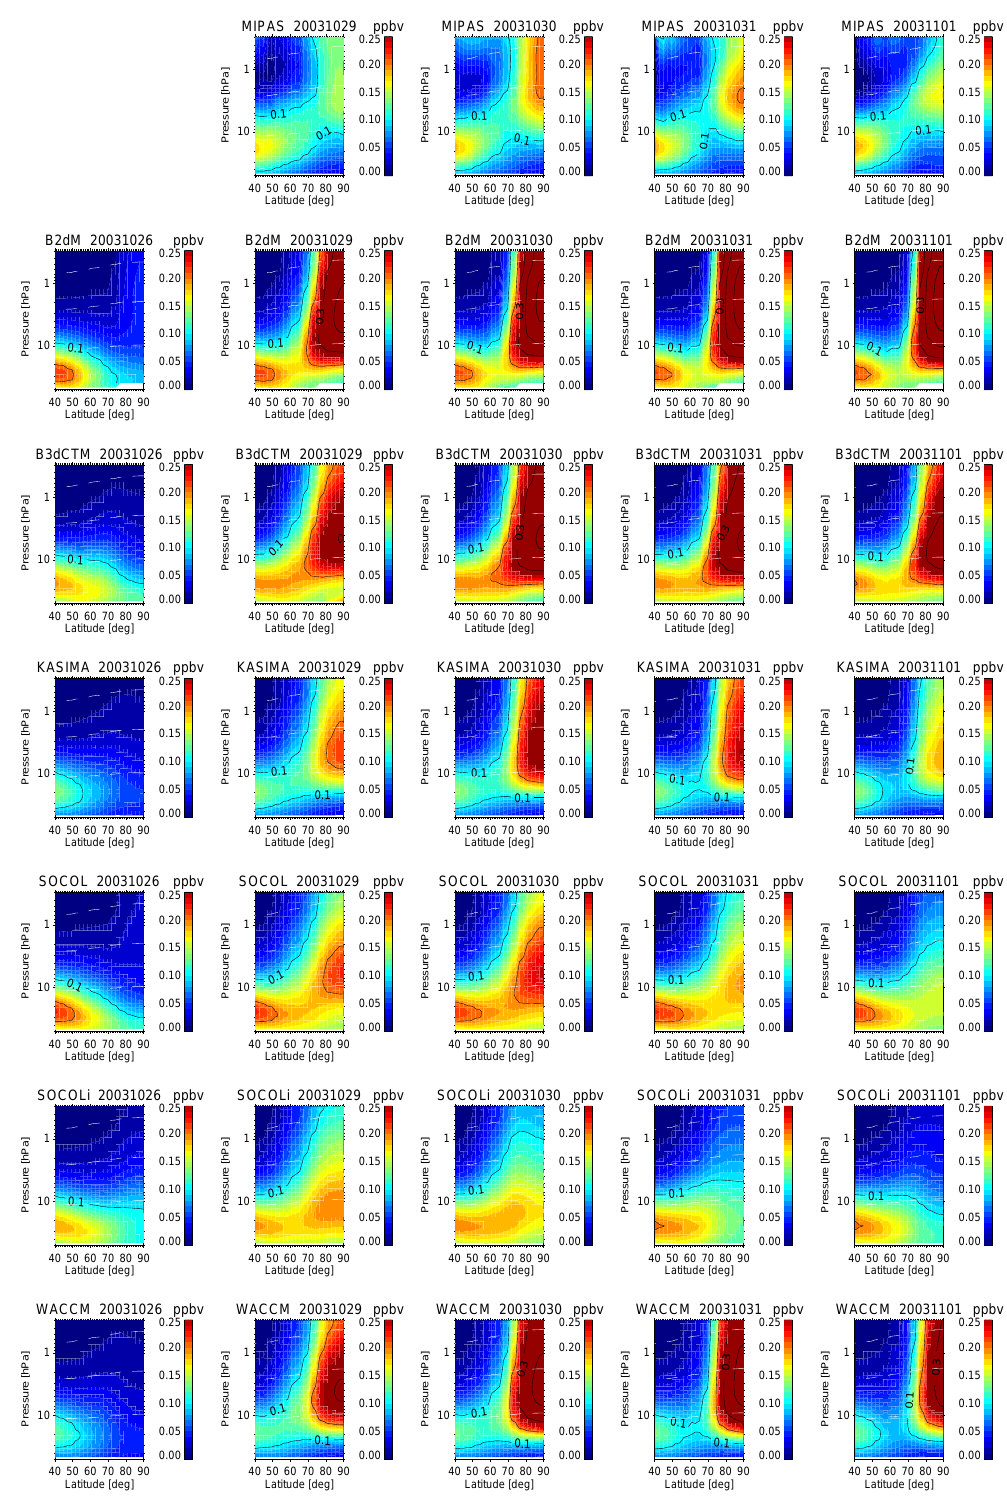
Fig. 25. Observed and modeled zonal mean HNO 4 vmrs for pre-SPE conditions (26 October) and during the main proton forcing (29 October–1 November). Solid contour lines reflect 0.1 ppbv steps. Note that MIPAS observations from 26 October have been omit- ted due to gain calibration problems.